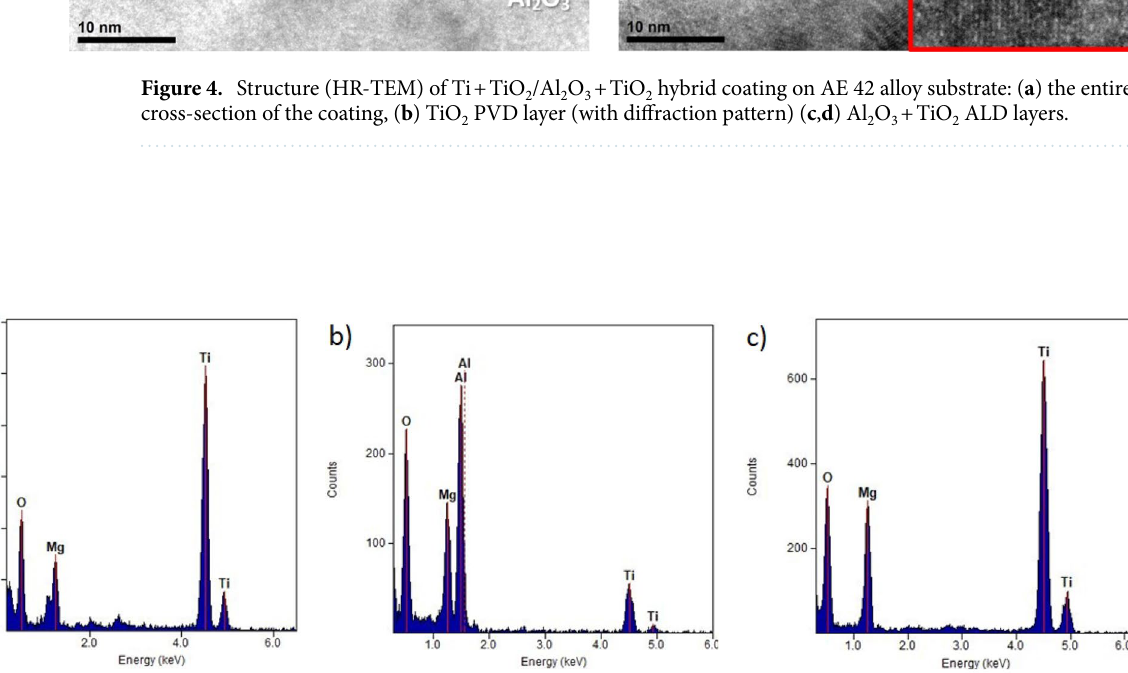
Figure 5. X-ray energy-dispersive plot as Fig. 4a of the area: ( a ) X1, ( b ) X2, ( c )